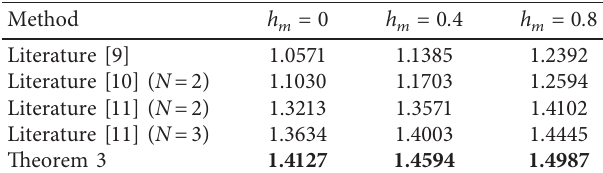
Figure 3: curve of x ( t ) when h ( t ) � 1 . 51 + 0 . 51 sin t . Table 4: In Example 3, when μ � any , MADB is simulated to be obtained for different h m and different